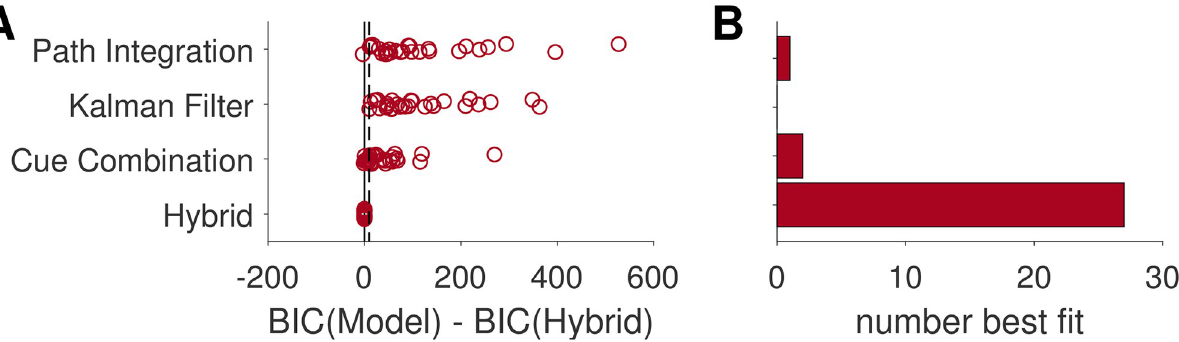
Fig 10. Model comparison. (A) BIC scores for each model relative to the BIC score for the Hybrid model for each participant. For each model, each circle corresponds to one participant. Positive numbers imply the fit favors the Hybrid model, negative numbers imply that the fit favors the other model. A Δ BIC value of > 10 (indicated by the dotted line) is considered “very strong” evidence implied by very high posterior odds ( P ( M > 0.99) [48]. (B) The number of participants best fit by each model. 28 out of 30 participants were best fit by the Hybrid model, suggesting that this model best describes human